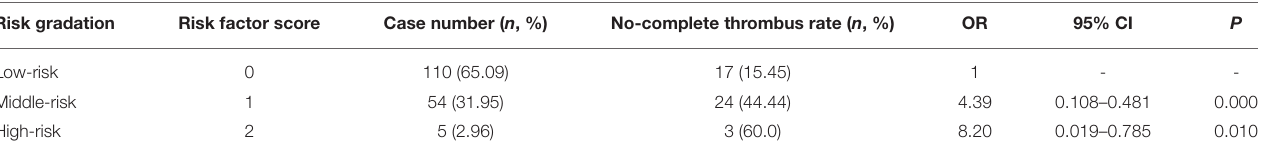
TABLE 3 | Risk gradation of the incomplete